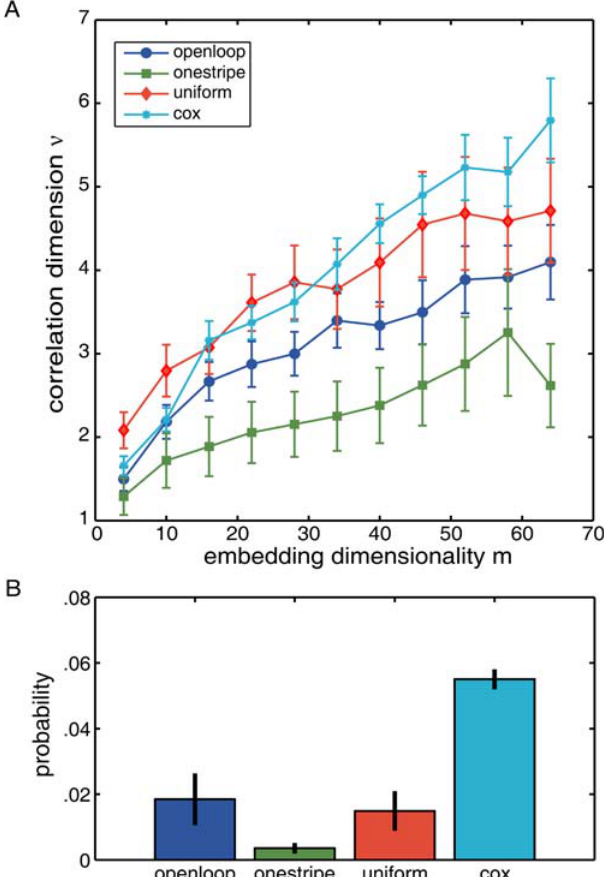
Figure 4. Correlation dimension. A–While the correlation dimension converges on a group-specific value with increasing embedding dimension for fly-generated ISIs ( openloop, onestripe, uniform ), a number sequence generated randomly by a Cox Process ( cox ) diverges. B– Probability to obtain the computed correlation dimensions in A by random shuffling of the original data. While the cox group exceeds an alpha value of .05, the three fly groups stay well below that threshold.